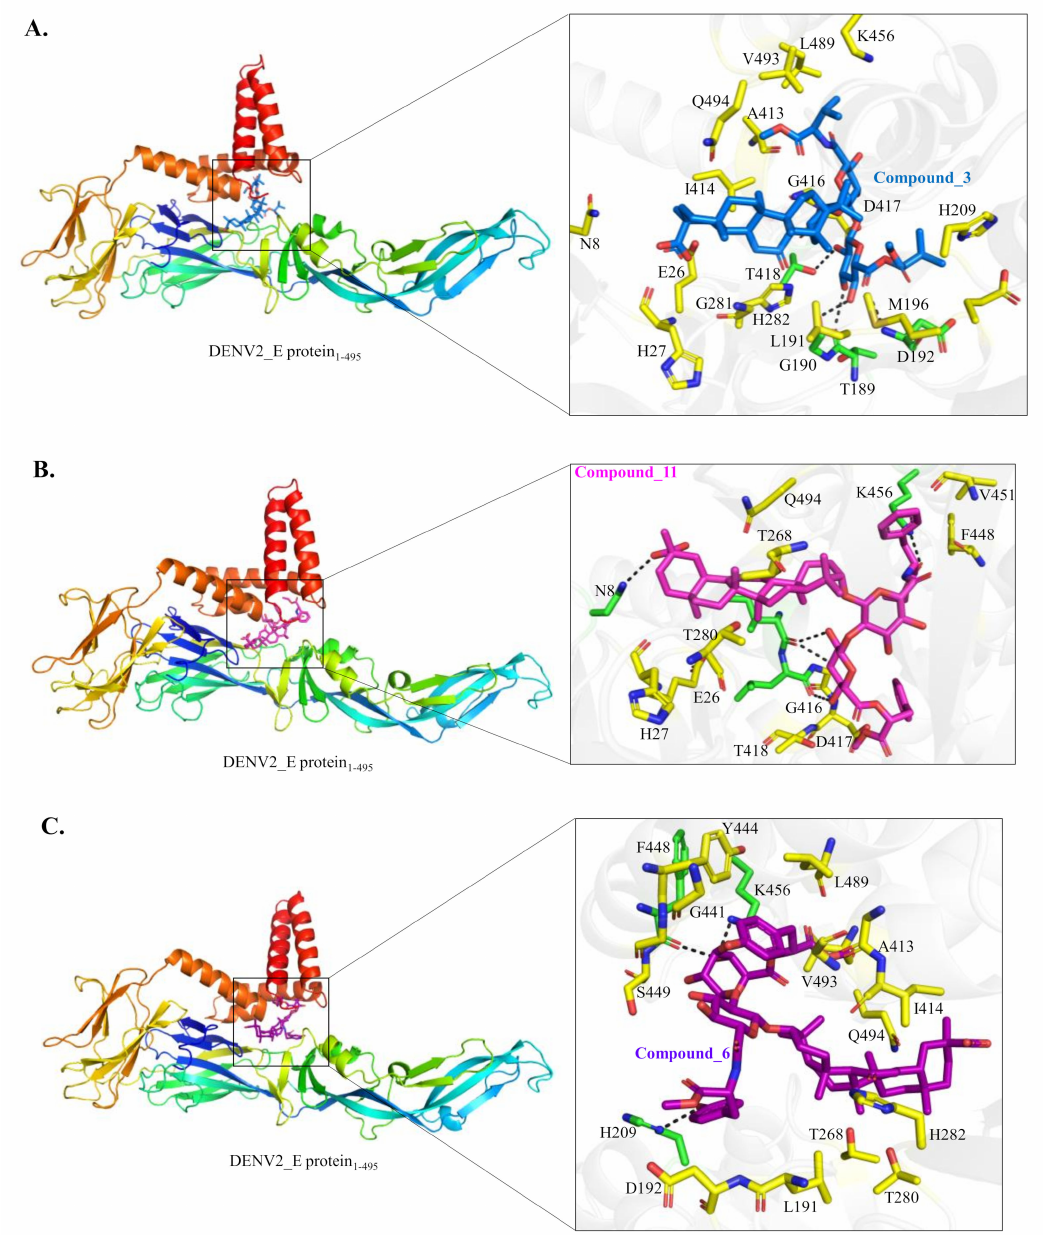
Figure 8. Molecular docking of Compounds 3, 6 and 11 into the β -OG binding pocket of DENV-2 E protein. The best docking pose of Compound 3 ( A ), Compound 11 ( B ), Compound 6 ( C ) to DENV-2 E protein (residues 1-495, PDB: 7KV8). Left, the docked protein-compound model; right, the enlarged view of the β -OG binding pocket. DENV-2 E protein is presented in cartoon and the compounds and interacting residues involved are shown in sticks (green for H-bond interaction; yellow for hydrophobic interaction) and